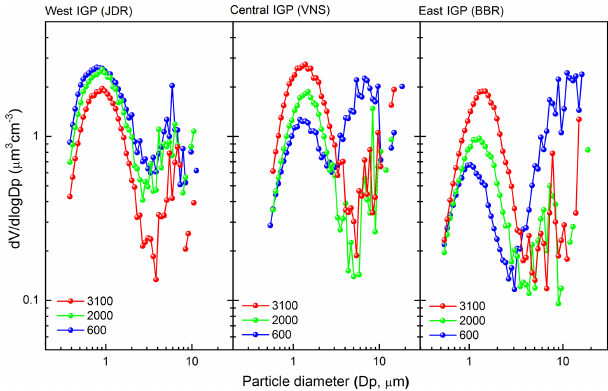
Figure 8. Aerosol volume size distributions (mean profiles averaged for all the days) at three distinct altitudes (600, 2000 and 3100m) of the atmosphere (shown by different color) over JDR, VNS and